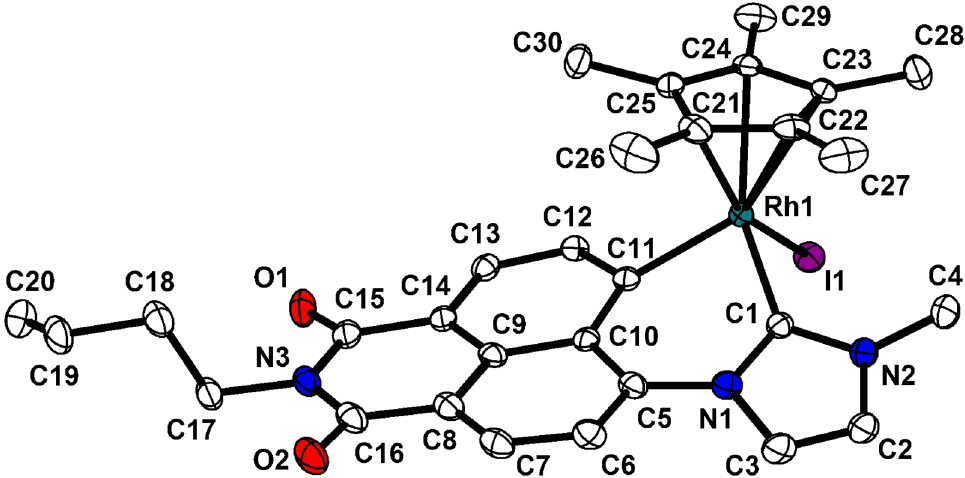
Figure 5. Molecular structure of ( S )- 2 with thermal ellipsoids drawn at the 30% probability level, hydrogen atoms were omitted for clarity. The asymmetric unit comprises two molecules with the same configuration and almost identical conformations, differing only in their nBu-groups. One molecule was arbitrarily chosen for representation. Selected average bond distances (Å) and angles (deg): Rh1-I1 2.699( 2 ), Rh1-C1 1.983( 5 ), C1-N1 1.371( 7 ), N1-C5 1.414( 6 ), C5-C10 1.426( 7 ), C10-C11